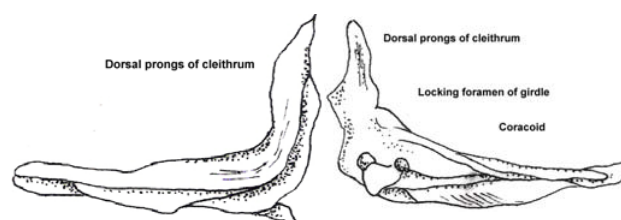
Figure 3. Suspensorium of Pterocryptis barakensis MPT - metapterygoid; EPT - endopterygoid;